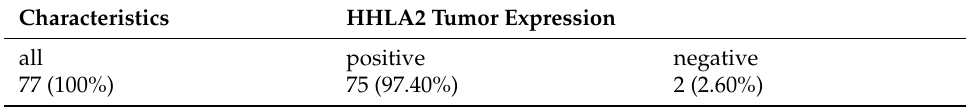
Table 2. HHLA2 Immunohistochemistry expression in tumor cells (N = 77).